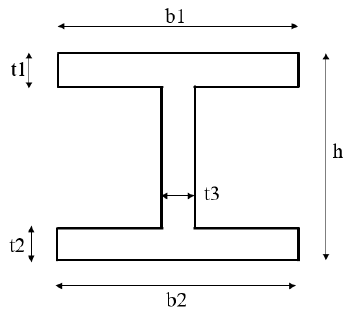
Table 4. Dimension parameters of each stringer.